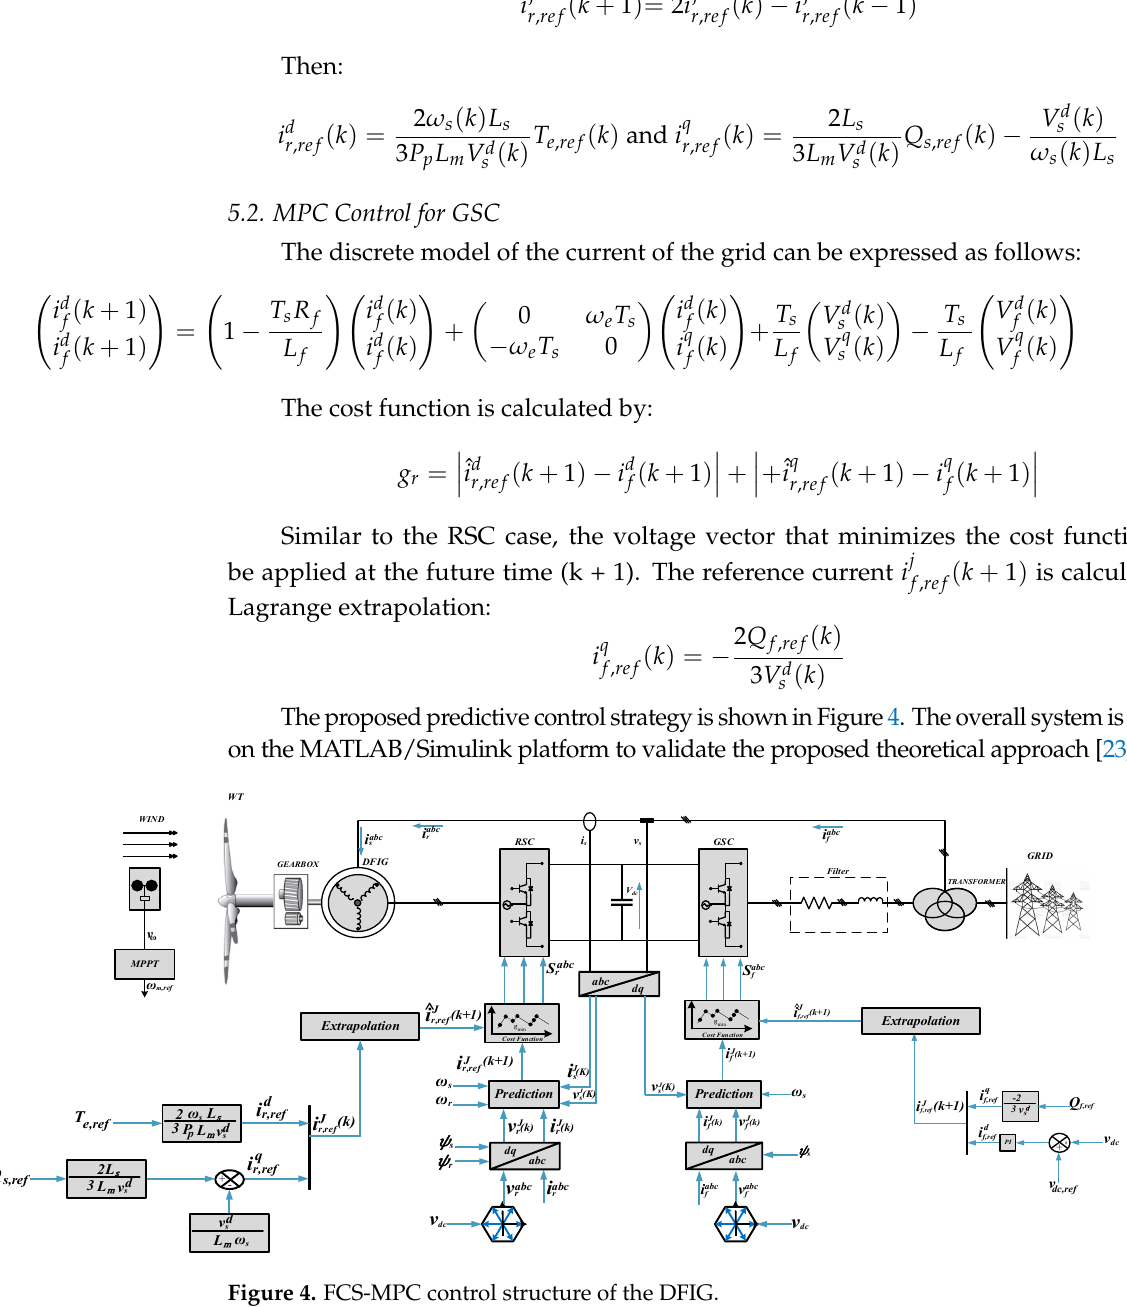
Figure 4. FCS-MPC control structure of the DFIG.